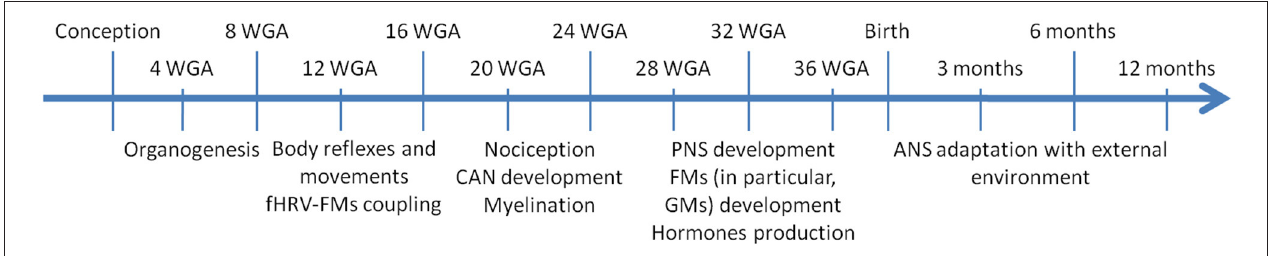
FIGURE 1 | Timeline of fetal and postnatal development that shows the main events related to ANS development in order to define the main critical windows clinicians should pay attention to. ANS, autonomic nervous system; CAN, central autonomic network; fHRV, fetal heart rate variability; FM, fetal movement; GM, general movement; PNS, parasympathetic nervous system; WGA, weeks gestational age.